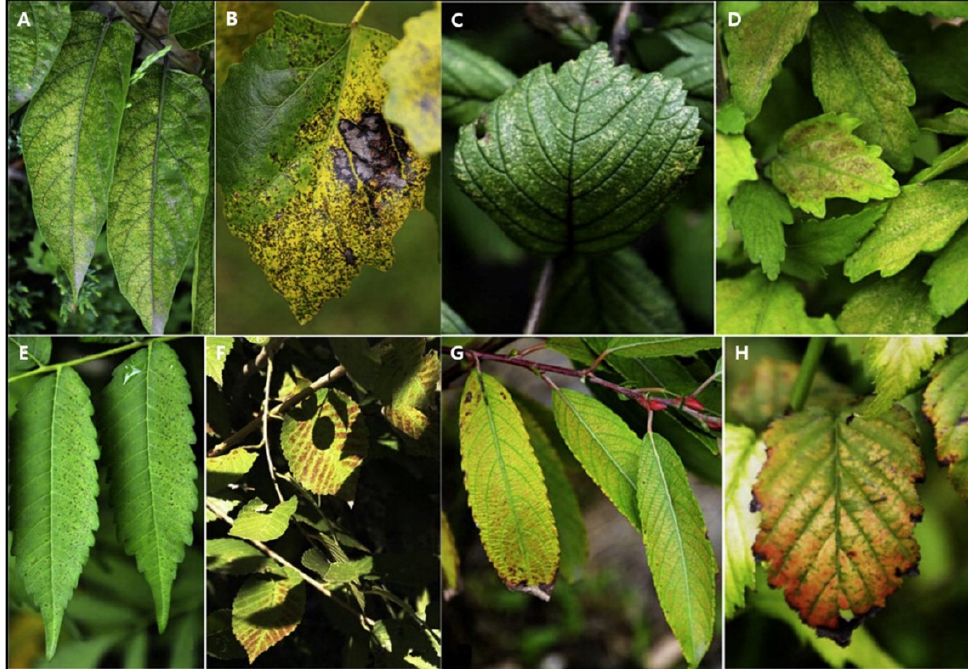
Figure 2. Visible symptoms of O 3 damage in O 3 -sensitive trees and shrubs around Beijing. ( A ) Ai- lanthus altissima ; ( B ) Populus tomentosa ; ( C ) Amygdalus triloba ; ( D ) Hibiscus syriacus ; ( E ) Rhus typhina ;